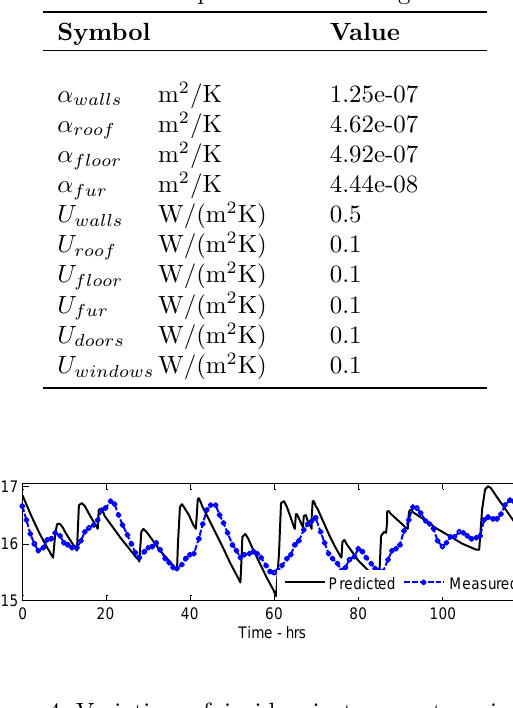
Figure 4: Variation of inside air temperature in the single-zone model [ 0